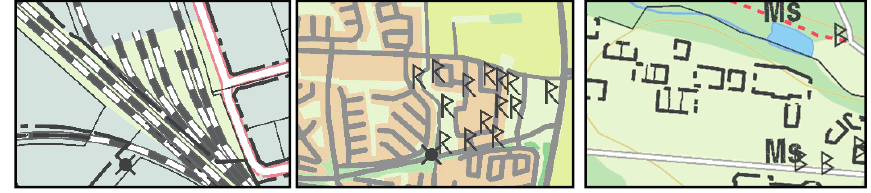
Figure 5. Maps that were often misclassified as readable: ( left ) maps with dense lines, ( middle ) maps with dense/overlapping symbols and ( right ) map with bad symbol types (of the cadastre